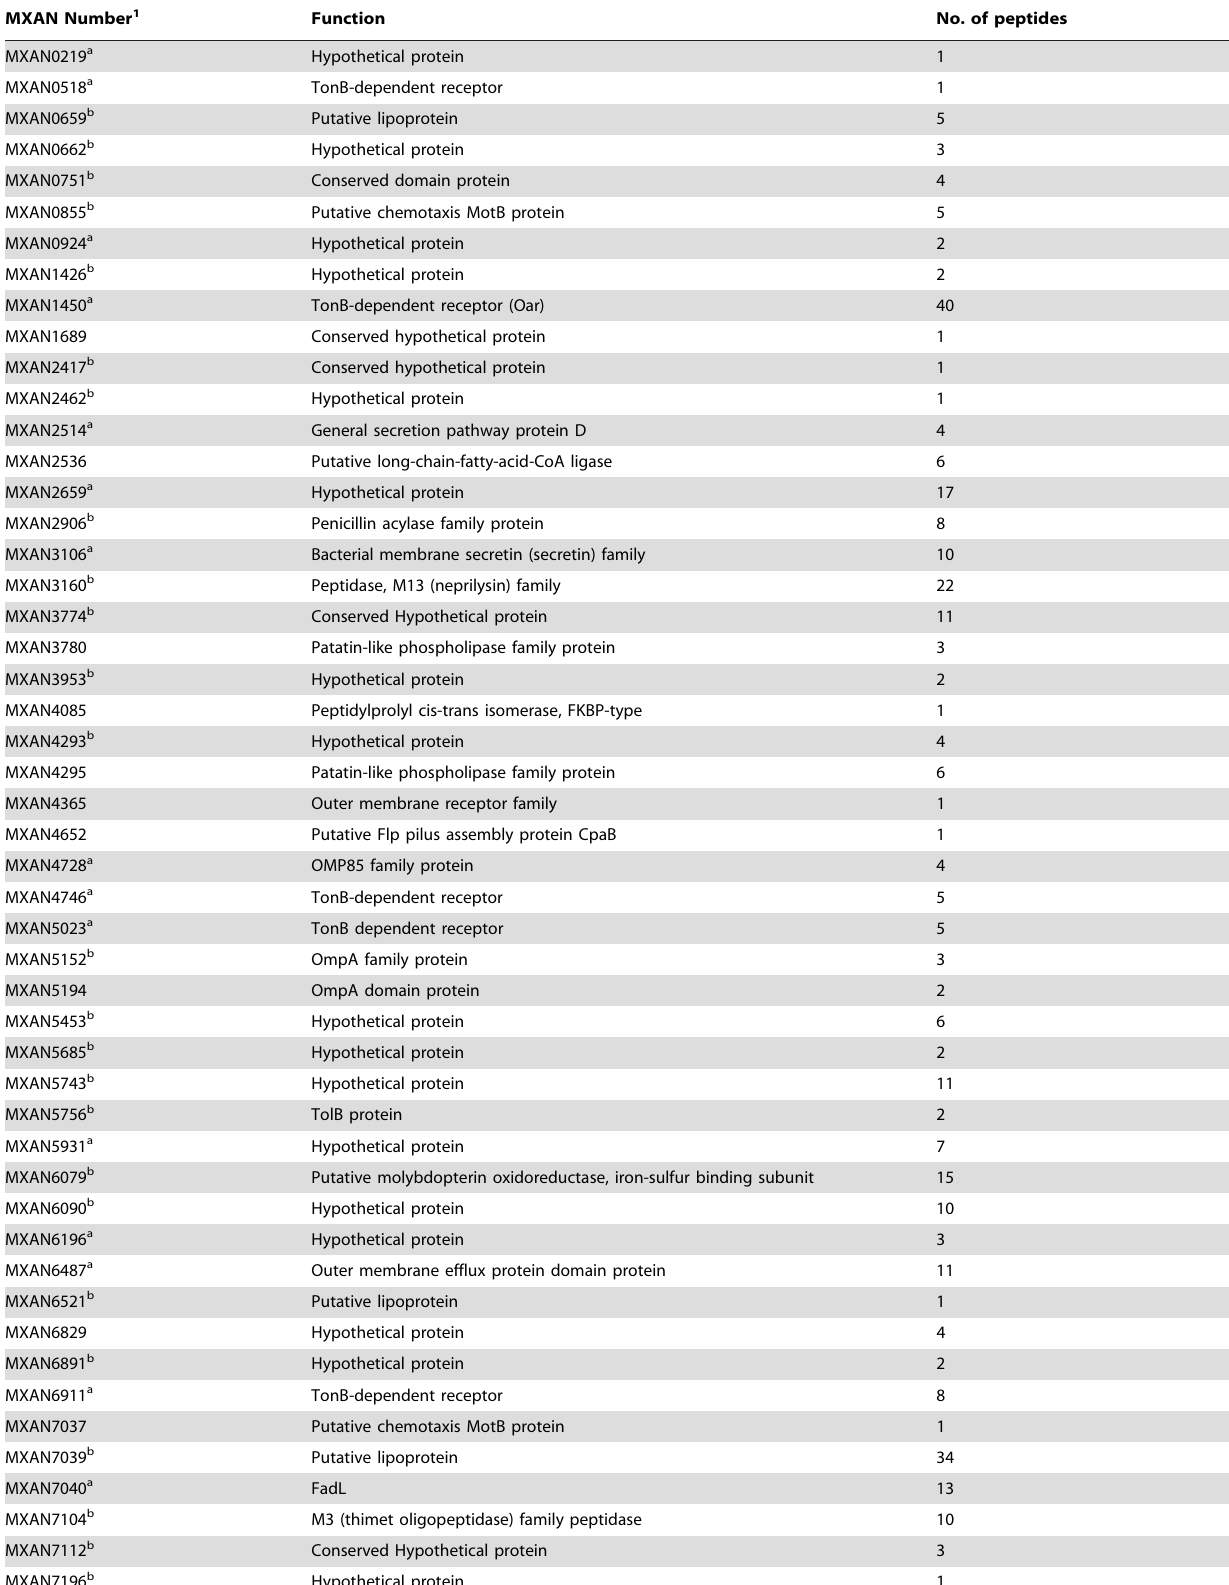
Table 3. OM b -barrel proteins identified by